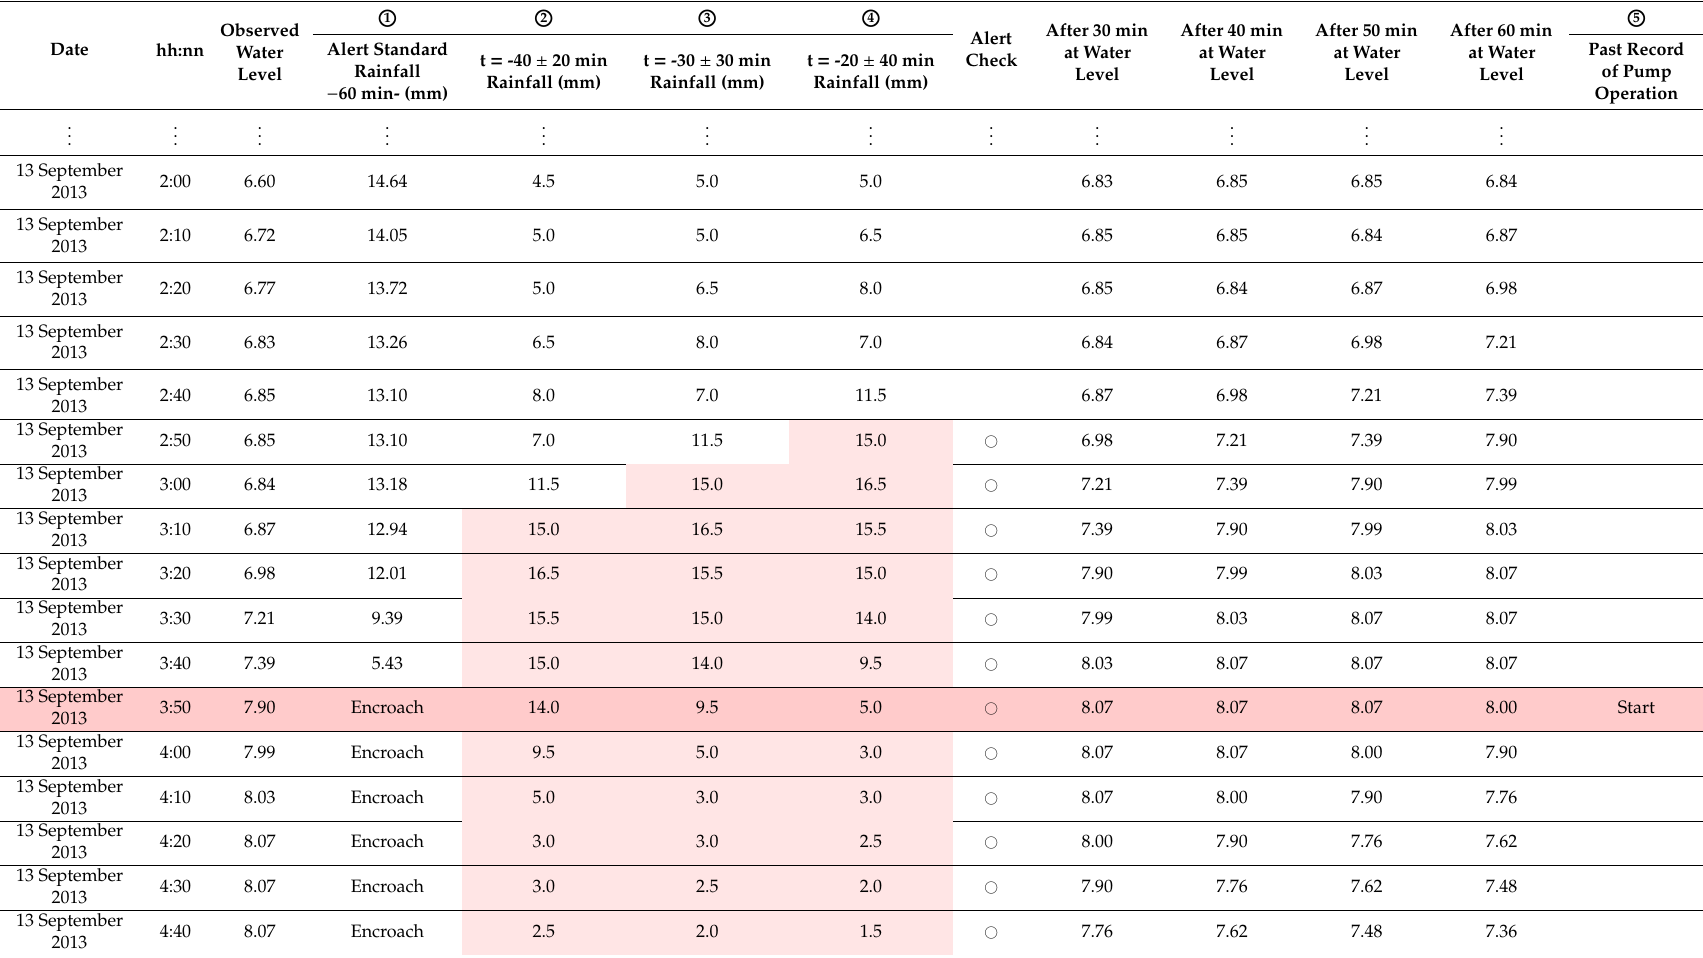
Table 13. Comparison of real-time water level observations in Dorim Stream (13 September